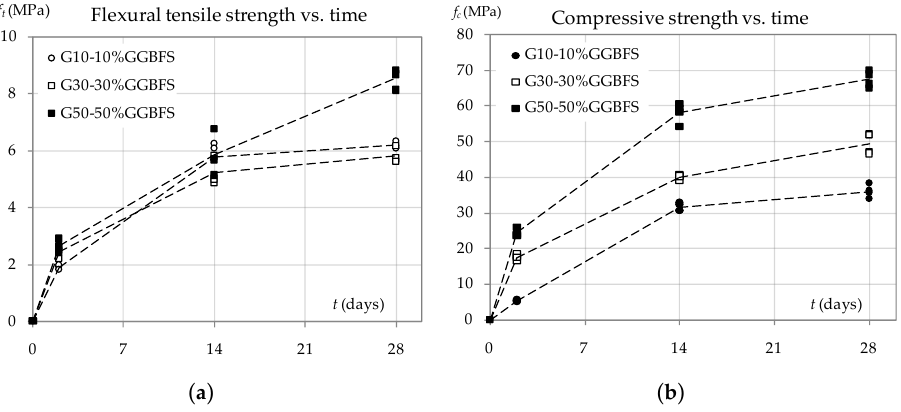
Figure 3. ( a ) Flexural tensile strength and ( b ) compressive strength.